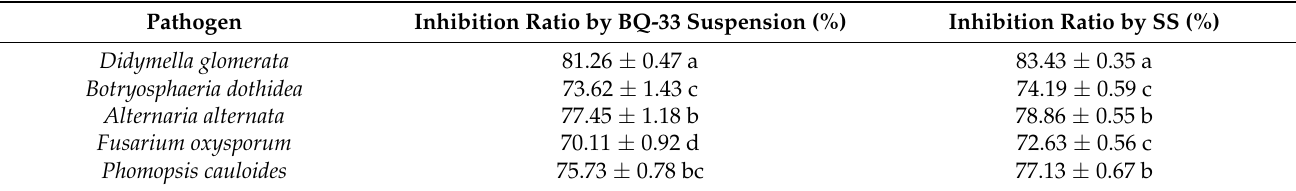
Table 2. Inhibitory ratio of QB-33 and its SS against fungal pathogens.